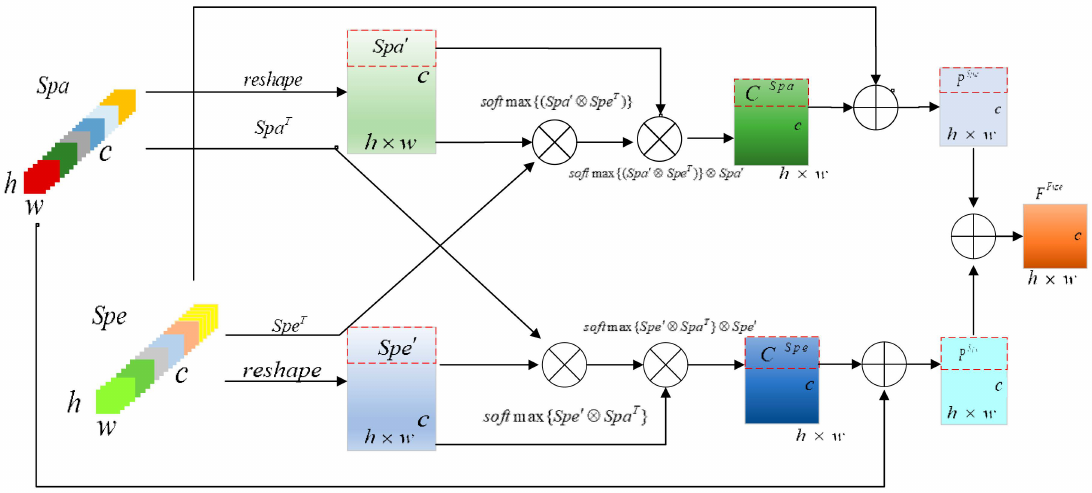
Figure 7. Schematic diagram of the information fusion